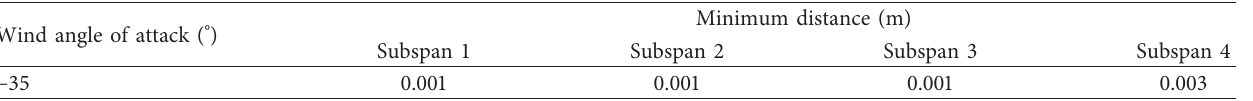
Table 7: The minimum distances at each subspan midpoint between two subconductors under the wind angle − 35 ° of attack ( I � 500A). Wind angle of attack ( ° )